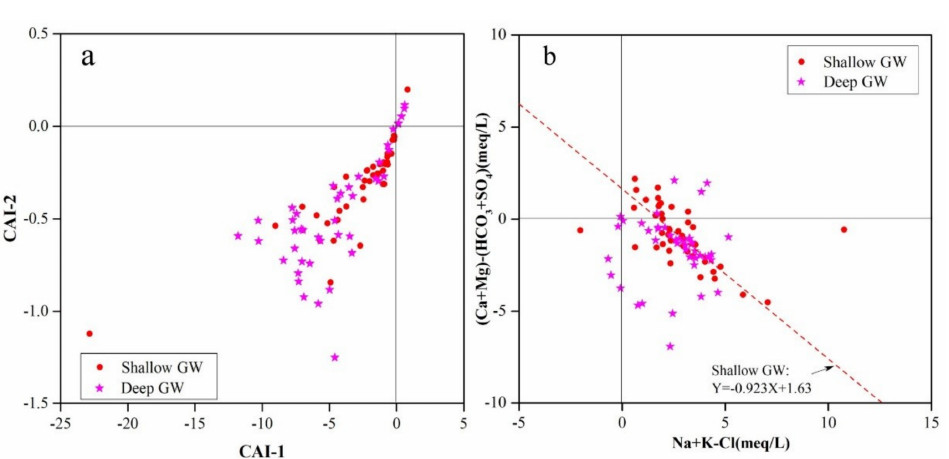
Figure 7. Plots of ( a ) CAI-1 against CAI-2 and ( b ) (Ca 2+ + Mg 2+ )-(SO 4 2 − + HCO 3 − ) versus Na + + K + -Cl −